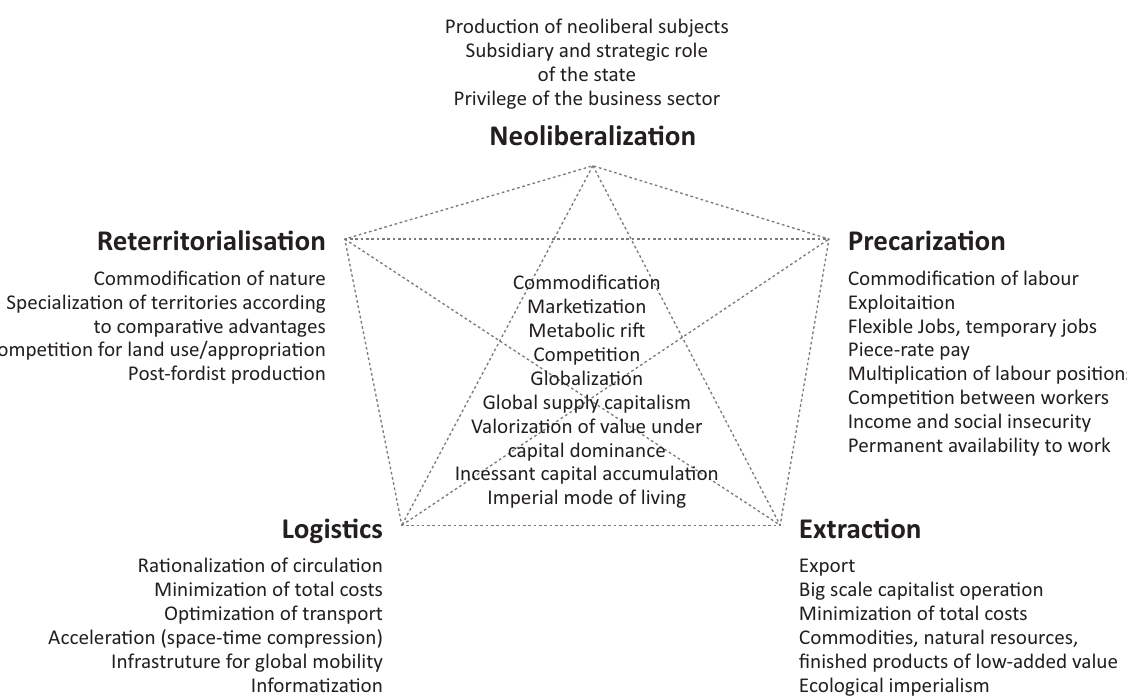
Figure 14. Logics of economic and social restructuring in Chilean port cities–hinterland territories. Source: Own elabora‐ tion based on Cuevas and Budrovich